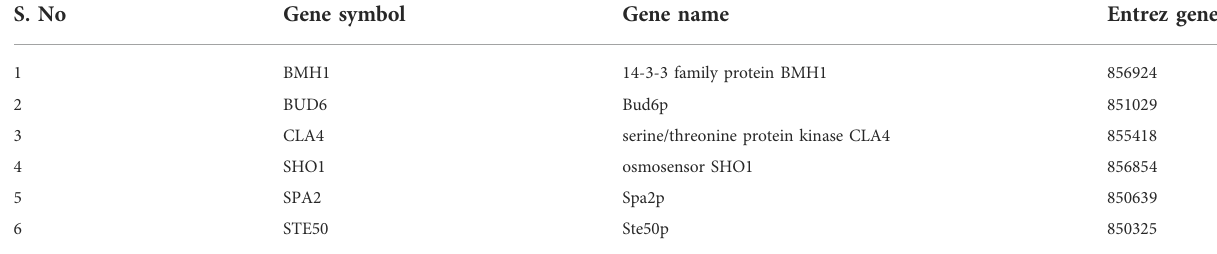
TABLE 2 GO Slim summary is based on Entrez gene IDs. S.